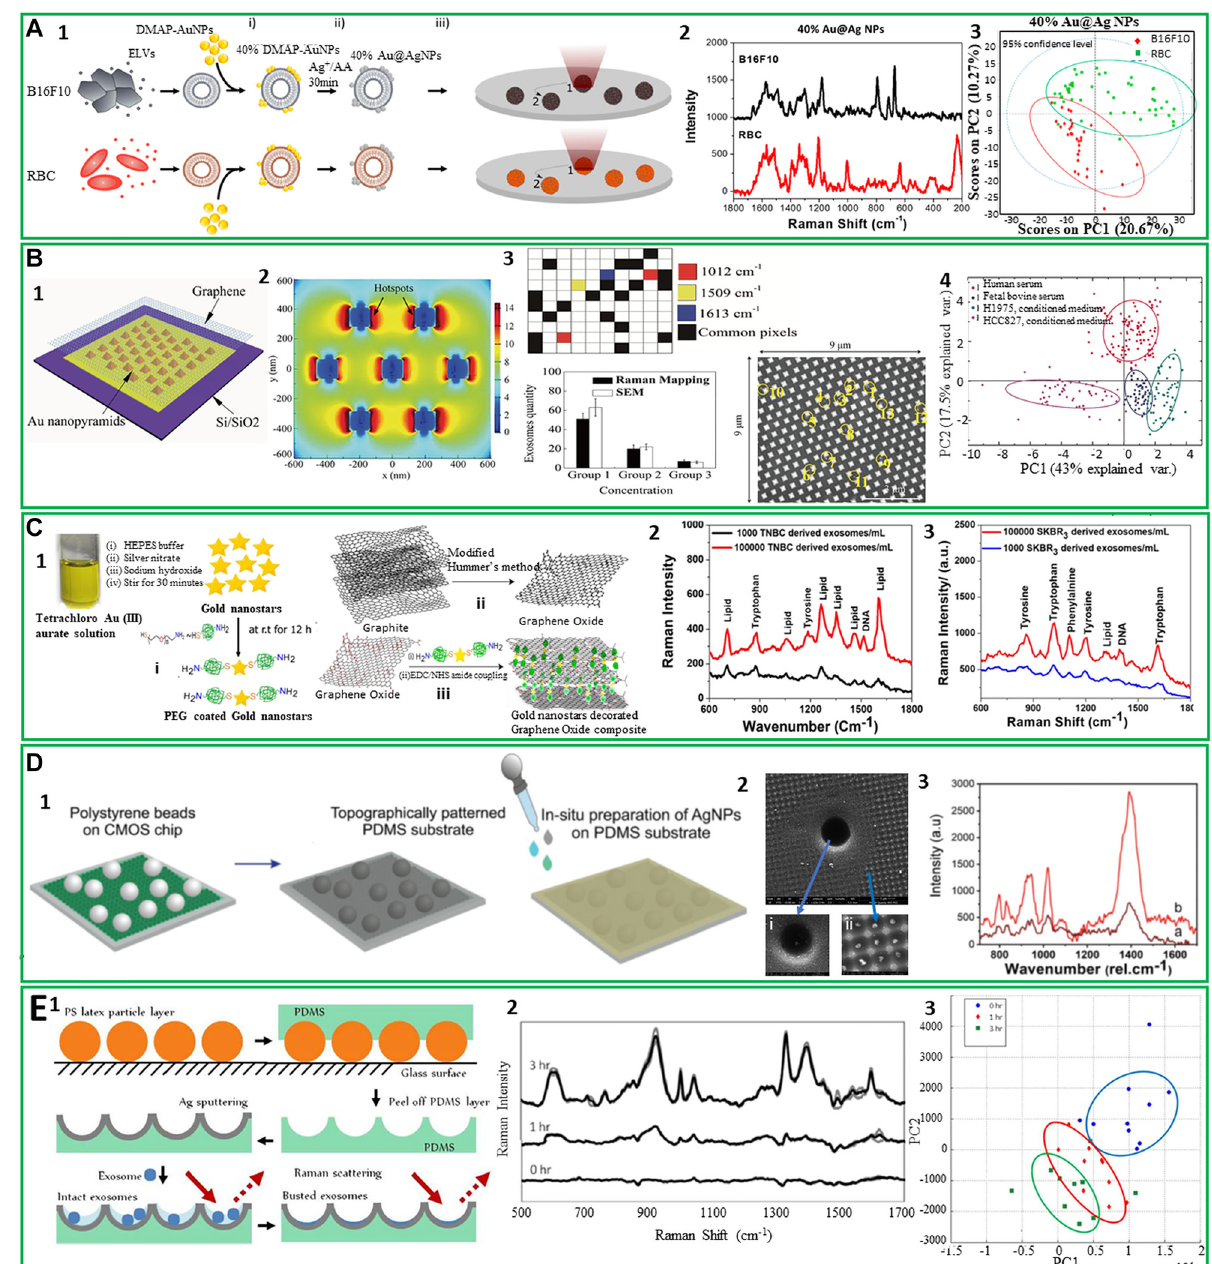
Figure 5: Label-free SERS characterization of EVs. (A) Functionalization and SERS analysis of EVs isolated from two types of cells; (A1) Schematic representation of the procedure for EVs functionalization;(A2)SERSspectraofindividualB16F10melanoma-andRBC-derivedEVs;(A3)The2DPCAforB16F10andRBCEVsAu@AgNPs (adapted with permission from [175]). (B) Fabrication of a hybrid platform for SERS investigation of EVs; (B1) Schematic diagram of the SERS hybridplatform;(B2)Electromagnetic fi elddistributionsimulatedbyFDTDfor785nmlaser;B3.SERSandSEMmappingofEVsadsorbedonthe hybrid substrate; the graph compares the EVs density obtained through Raman mapping and SEM at three different EVs concentrations. SEM micrographofEVsattachedtothegraphene-coveredsurface,wheretheyellowcirclesmarkthepresenceofEVswithinthisregion.Thecolored pixels represent the presence of selected peaks in the Raman spectrum; B4. PCA analysis of EVs from different sources (adapted with permission from [177]). (C) Synthesis and analysis of EVs on a mixed metal – graphene substrate; (C1) Schematic representation of the synthesisof PEG-coated goldnanostars;(C2)SERSspectraof EVs isolatedfrom TNBCcells (10 5 and10 3 cell/ml)onthe fabricatedsurface;(C3) SERS spectra of EVs obtained from SKBR3 cells (10 5 and 10 3 cell/ml) on the developed surface (adapted with permission from [180]). (D) Fabrication of a superhydrophobic substrate for EVs concentration and analysis; (D1) Schematic illustration of the substrate fabrication containing micro and nanobowls; (D2) SEM image of the AgNPs grown on the patterned PDMS substrate; insets show the AgNPs grown